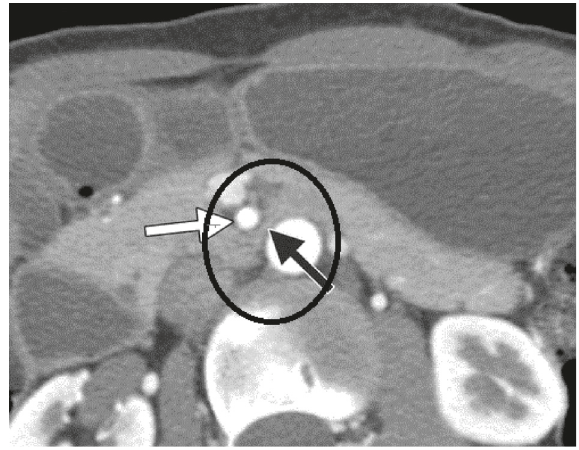
Figure 2: CT scan (axial view) with duodenal compression (black arrow) between the aorta and superior mesenteric artery (white